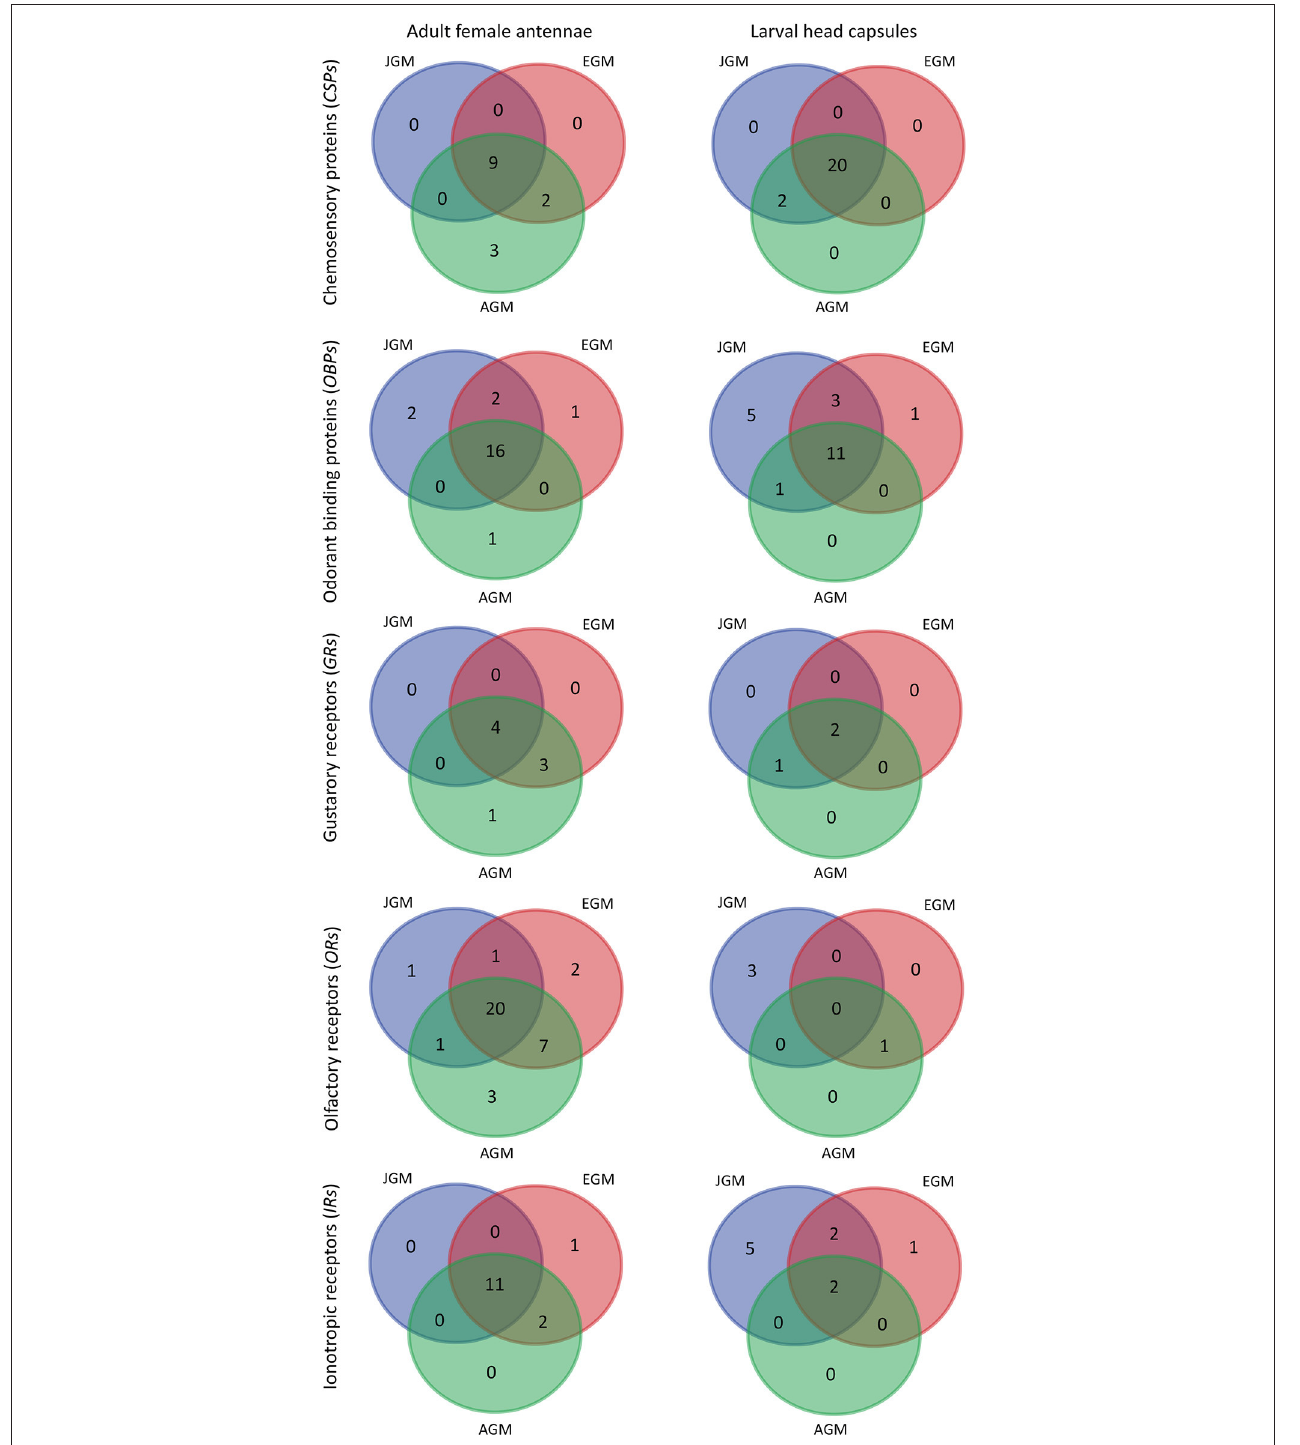
FIGURE 1 | Shared and exclusively expressed genes for three populations of the Gypsy moth for different classes of olfaction-related gene families in both female antennae and larval head capsules.